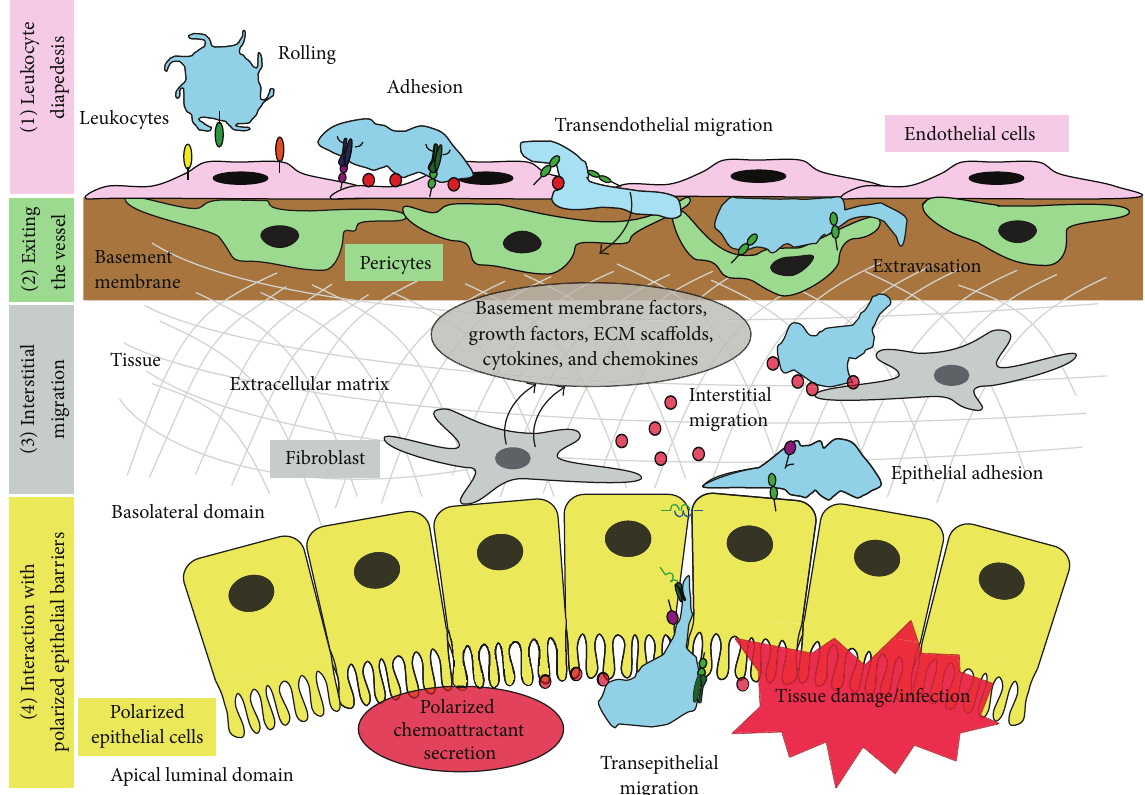
Figure 1: Endothelial and epithelial barriers determine the different stages of leukocyte migration in its journey towards the inflammatory focus in complex tissues. The parenchymal three-dimensional organization contributes to establish an haptotactic and chemotactic gradient (1) Leukocyte adhesion and transendothelial migration or diapedesis. (2) Exiting the vessel. Once they reach the subendothelial space, leukocytes traverse the basement membrane and interact with pericytes, which promote the complete extravasation of immune cells via adhesion receptors. (3) Interstitial migration. Leukocytes switch from a two-dimensional to a less adhesive three-dimensional migration to circumvent topological constraints in the stromal barrier. Fibroblasts help leukocyte navigation by maintaining protein scaffolds and secreting mediators such as cytokines and growth factors, which act as chemotactic cues. (4) Interaction with polarized epithelial barriers. Following haptotactic and chemotactic gradients, leukocytes encounter polarized epithelial cells and often undergo transepithelial migration. The polarized distribution of the adhesive and chemotactic machineries mediates leukocyte guidance through the parenchymal epithelia for immunosurveillance or the clearance of pathogens and dysfunctional